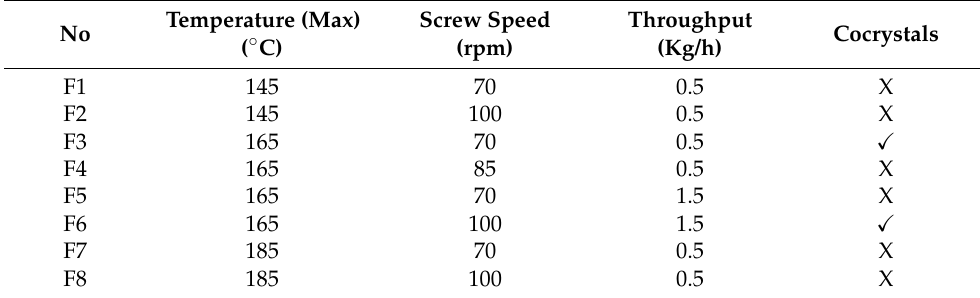
Table 1. Scale-up trials of theophylline–nicotinamide (THL-NIC) cocrystals by investigating the effect of critical process